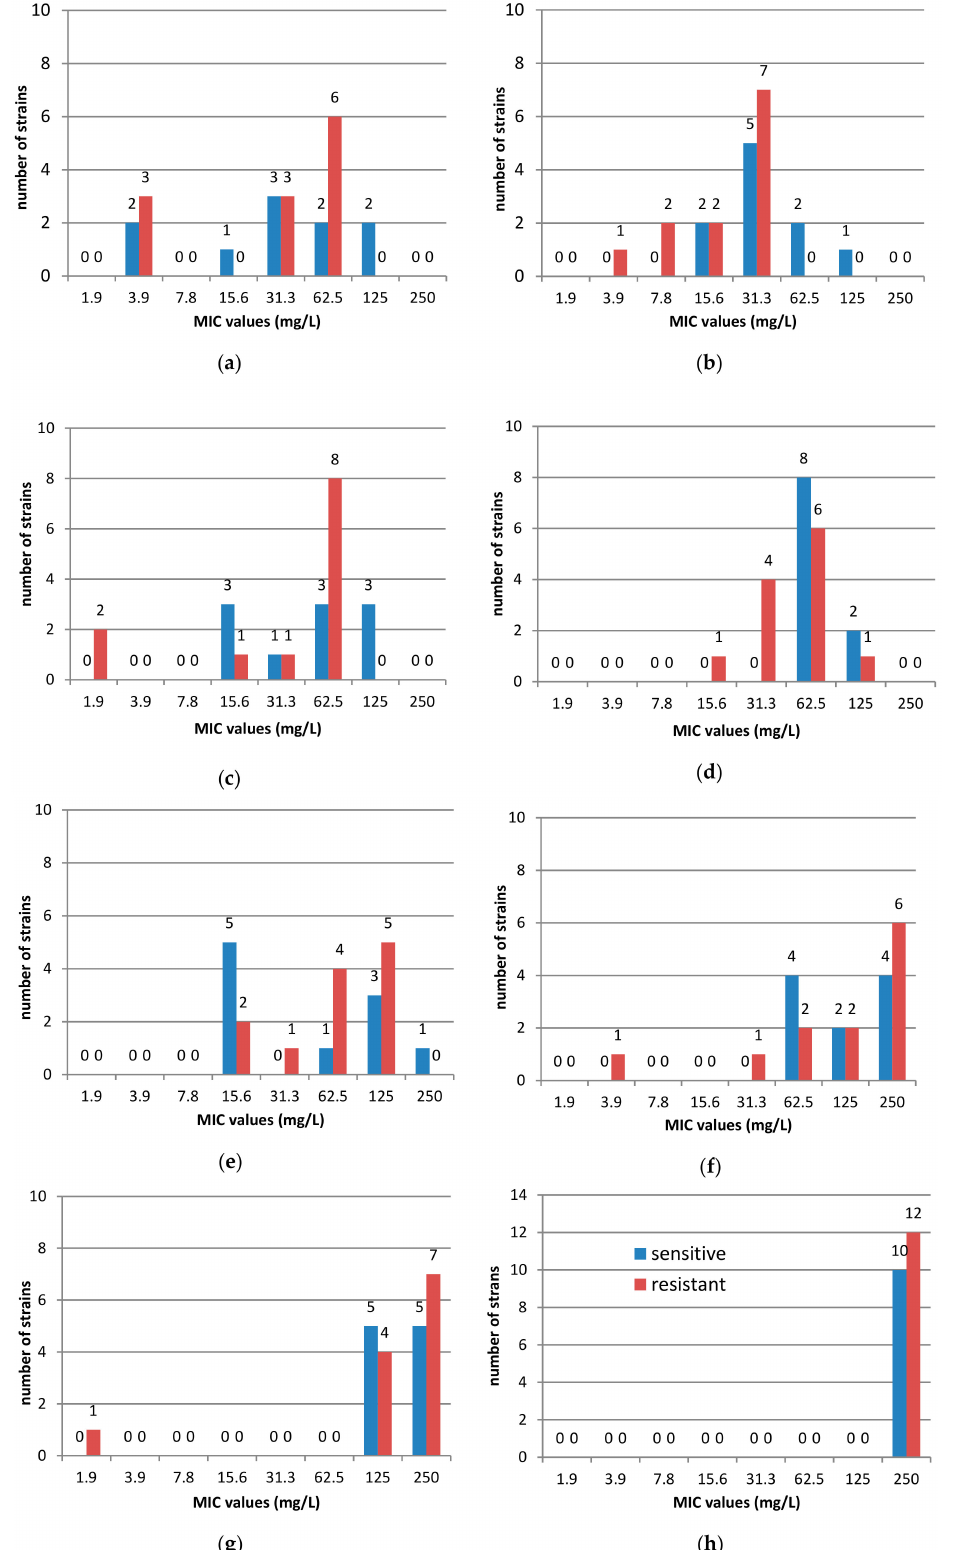
Figure 2. Susceptibility of 22 clinical H. pylori strains to essential oils in MIC values (mg / L): ( a ) cedarwood oil; ( b ) oregano oil; ( c ) thyme oil; ( d ) lemongrass oil; ( e ) lemon balm oil; ( f ) tea tree oil; ( g ) lemon oil; ( h ) pine and fir